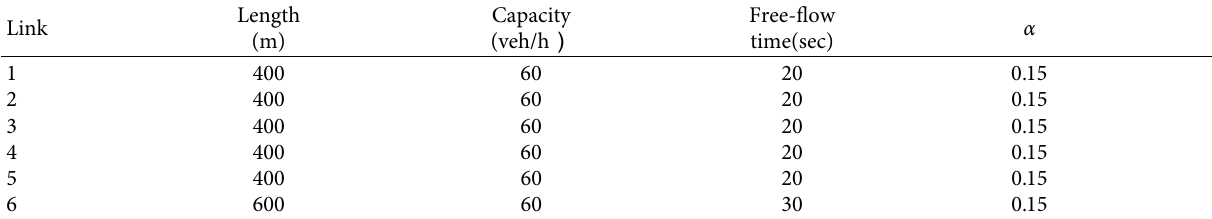
Table 1: The properties of links.